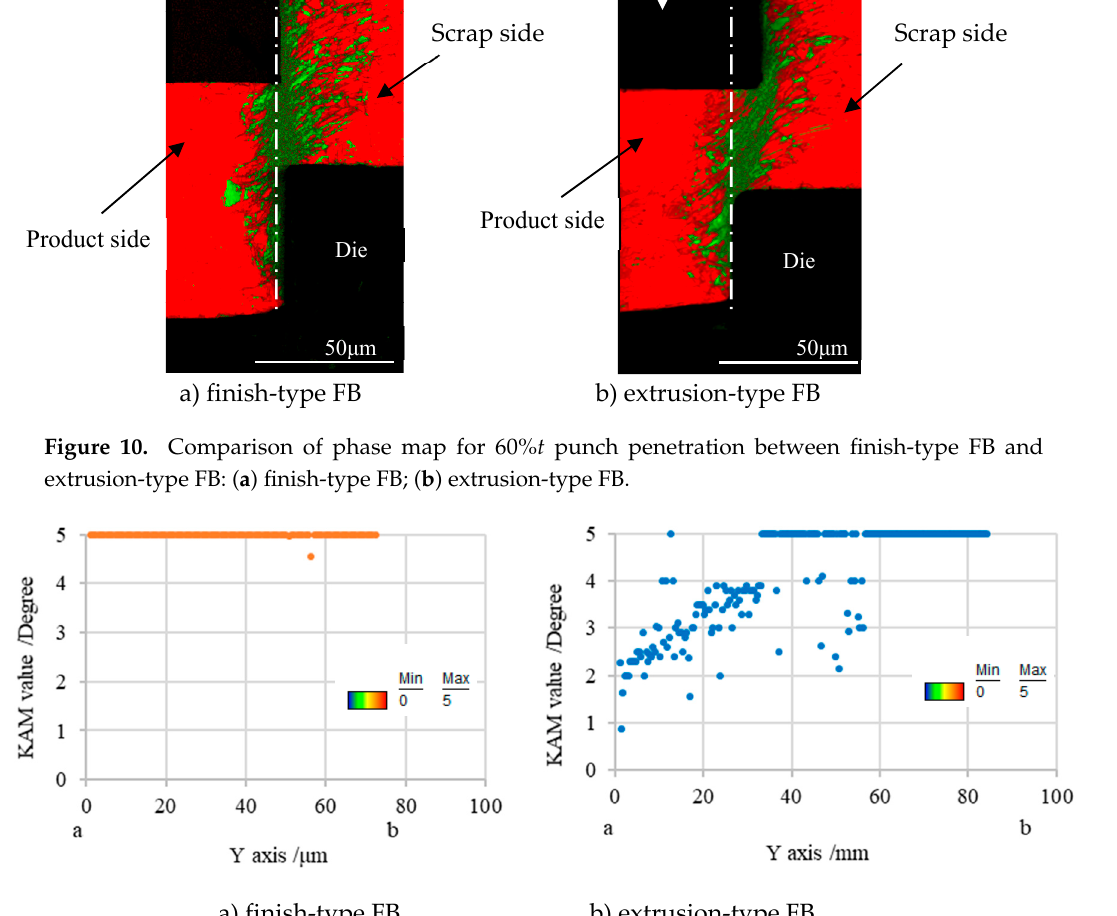
Figure 11. Comparison of KAM values between a and b of Figure 7: ( a ) finish-type FB; ( b ) extrusion-type FB.